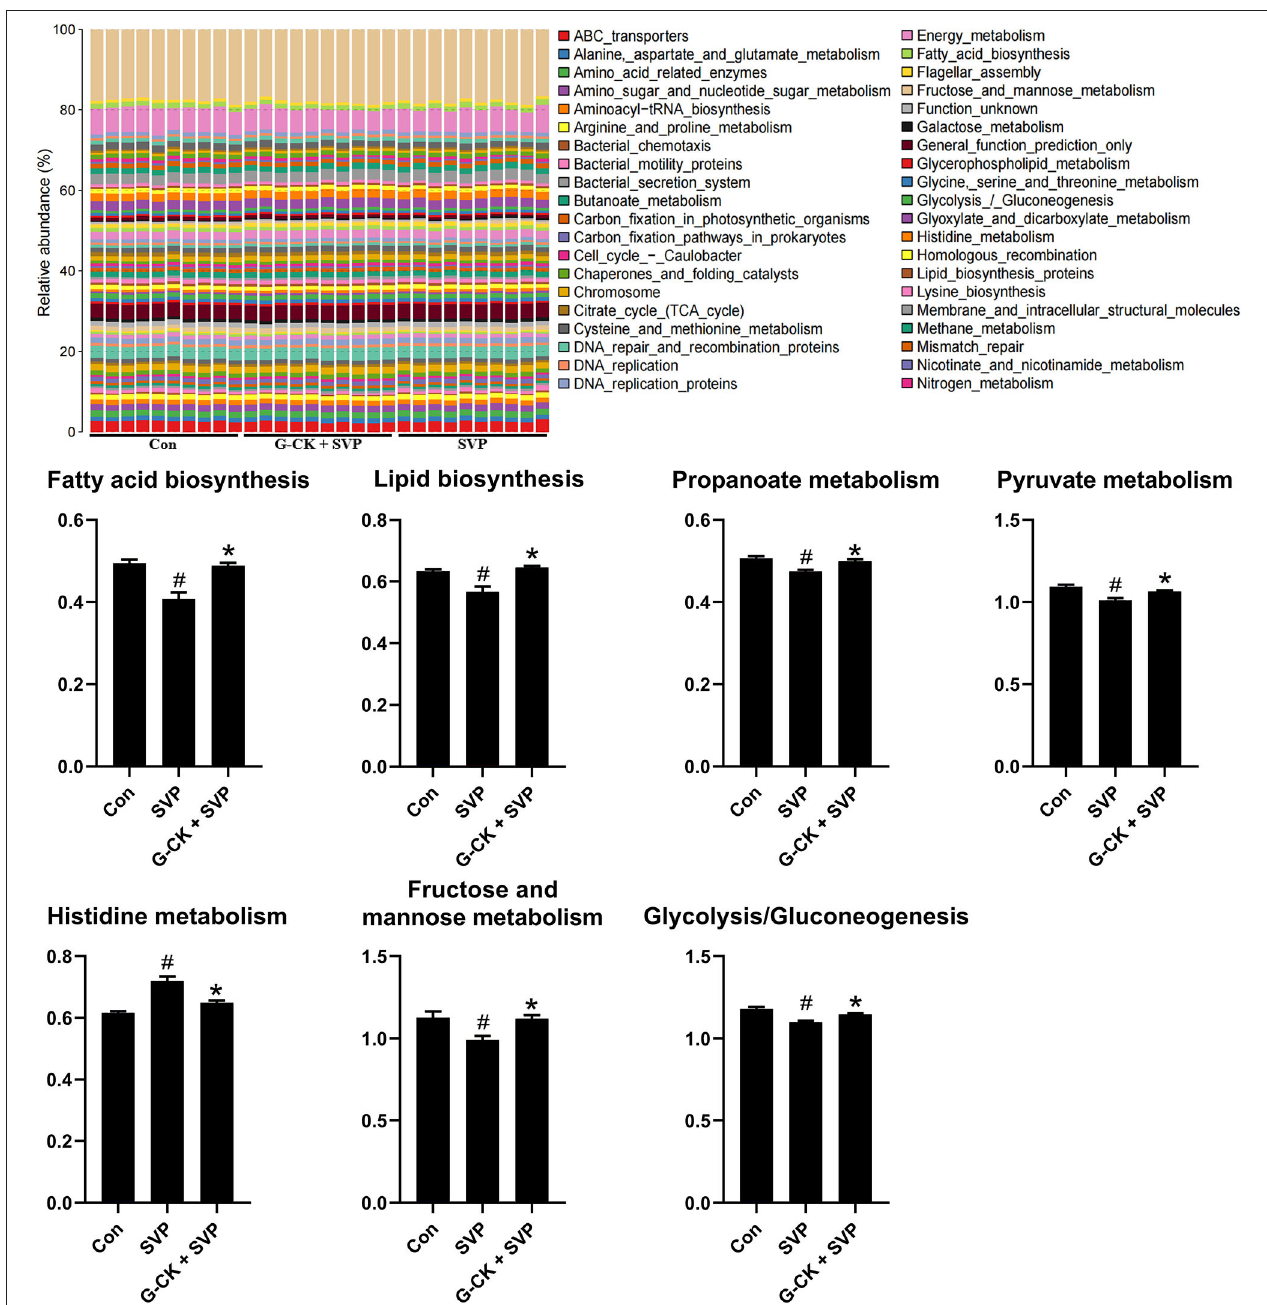
FIGURE 3 | PICRUSt analysis of gut microbiota. Values are mean ± SD, n = 10. Con, control; SVP, sodium valproate (500 mg/kg, twice daily); G-CK, ginsenoside compound K (320 mg/kg, once daily). # p < 0.05 vs. Con group, * p < 0.05 vs. SVP group.